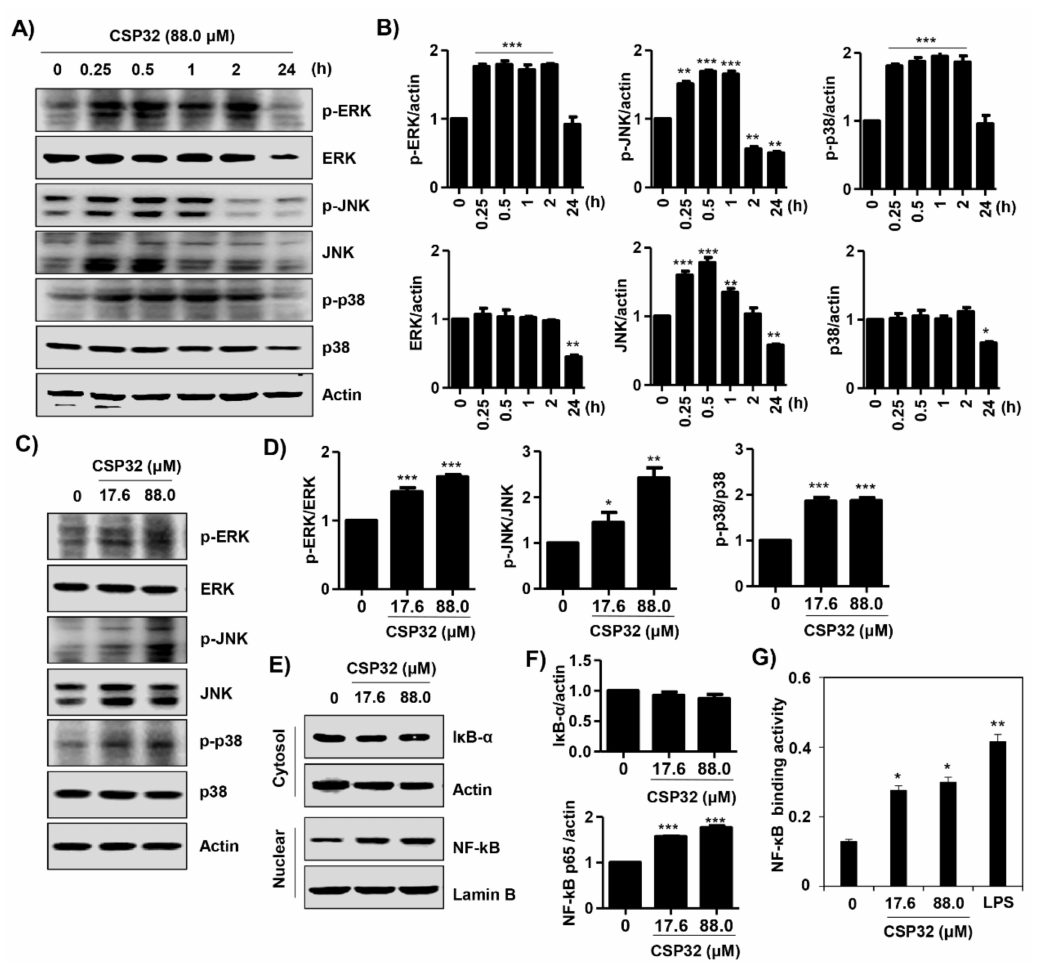
Figure 4. CSP32 activated MAPKs and the NF- κ B signaling pathway in macrophages. ( A ) At 0, 15 min, 30 min, 1 h, 2 h, and 24 h after CSP32 treatment, cells were harvested and lysed. ( C , E ) Cells were treated with the indicated concentration of CSP32 for 1 h and subsequently harvested and lysed. ( A , C ) Total cell lysates were examined by western blotting for ERK, JNK, and p38 MAPK phosphorylation. β -actin was used as an internal control. ( E ) Cytoplasmic and nuclear lysates were examined by western blotting for I κ B- α and NF- κ B. Actin and lamin B1 serve as the internal controls for the cytoplasmic and nuclear lysates, respectively. ( B , D , F ) Quantitative analysis of protein expression. The expression of each protein was indicated as a fold change relative to the control. Data are expressed as the mean ± SD ( n = 3). * p < 0.05, ** p < 0.01 and *** p < 0.001 compared with the control. ( G ) In nuclear lysates, NF- κ B